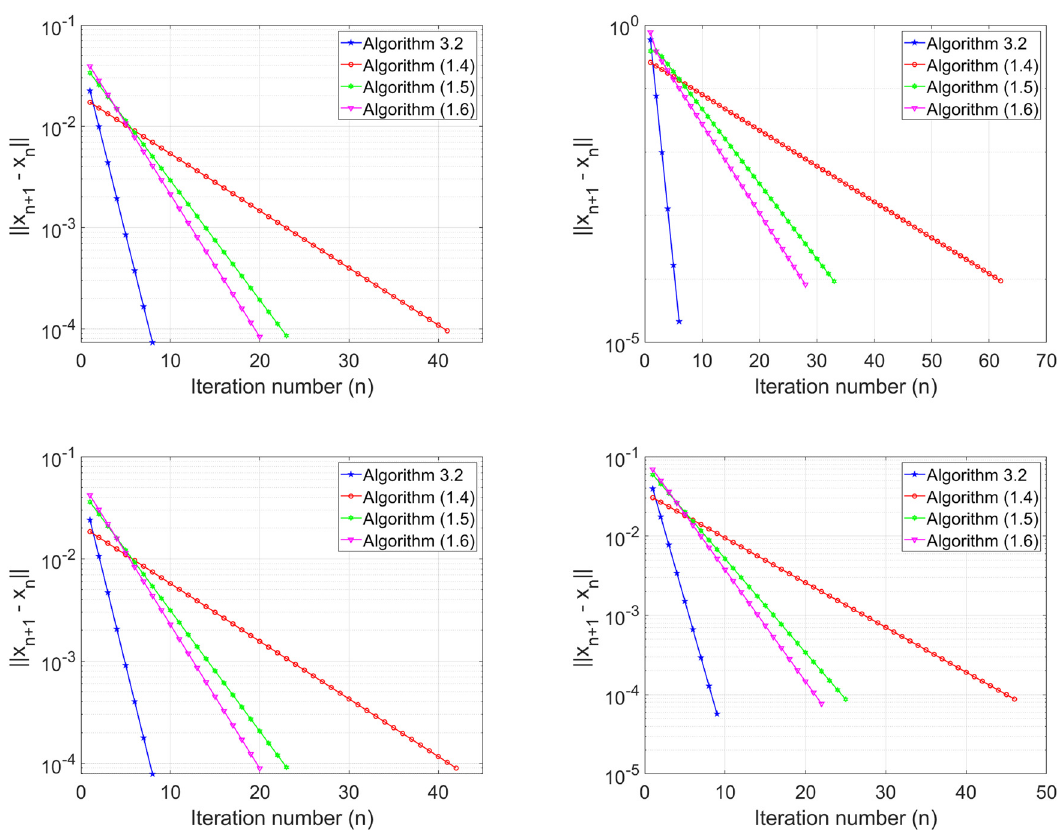
Figure 4: Example 4.2, Experiment 2, top left: Case I; top right: Case II; bottom left: Case III; bottom right: Case